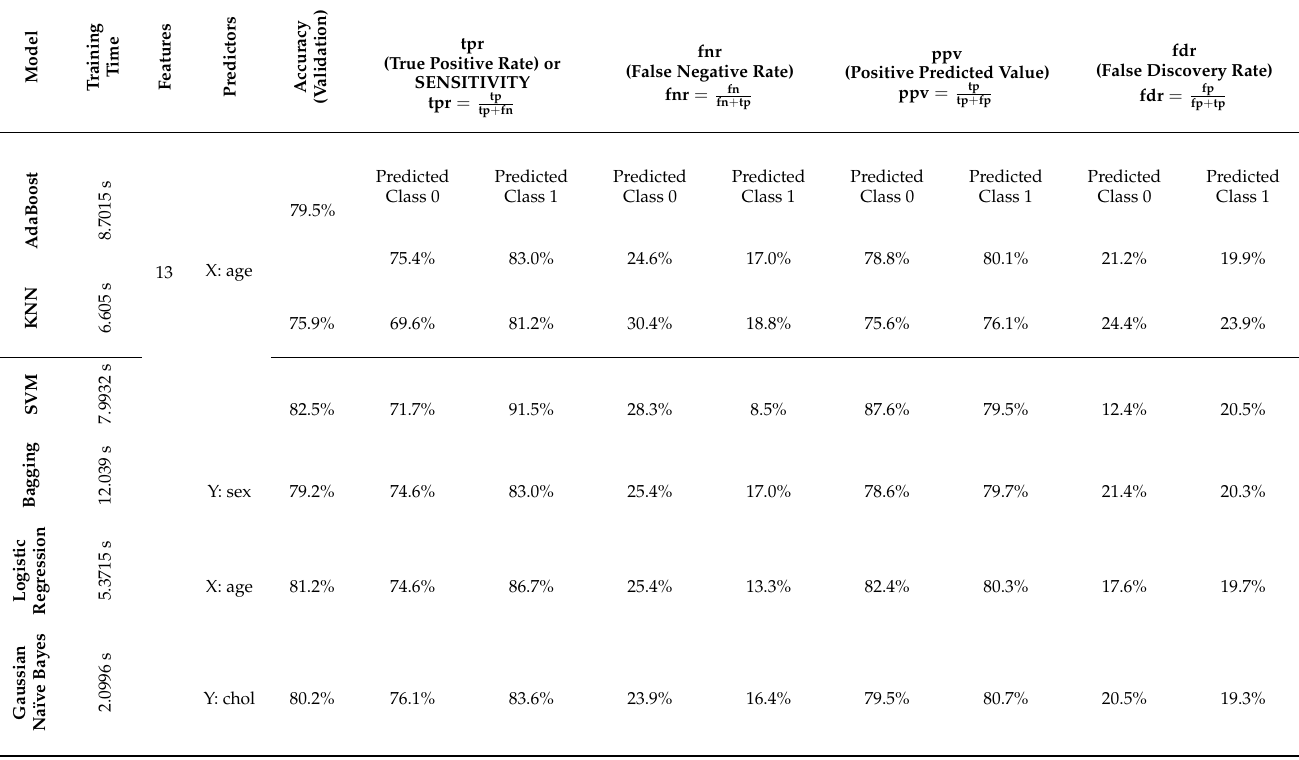
Table 4. Comparative analyses of the ensemble classification